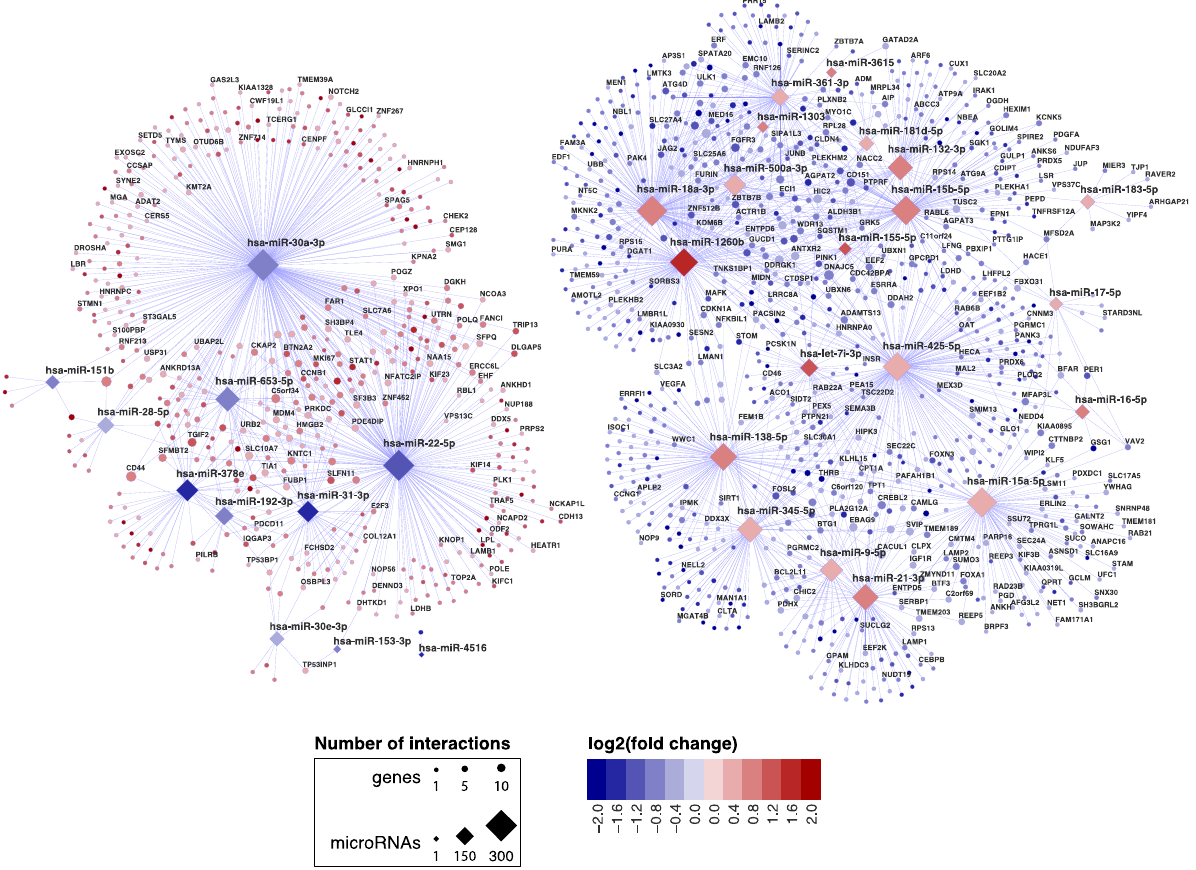
Figure 2. miRNA–target transcript network in small intestinal biopsies. This network shows the 2030 miRNA–target transcript pairs that were selected by the workflow in Figure 1. Only the gene names of experimentally validated target transcripts are shown. Supporting data for the miRNA-mRNA pairs are shown in Supplementary Table S1.